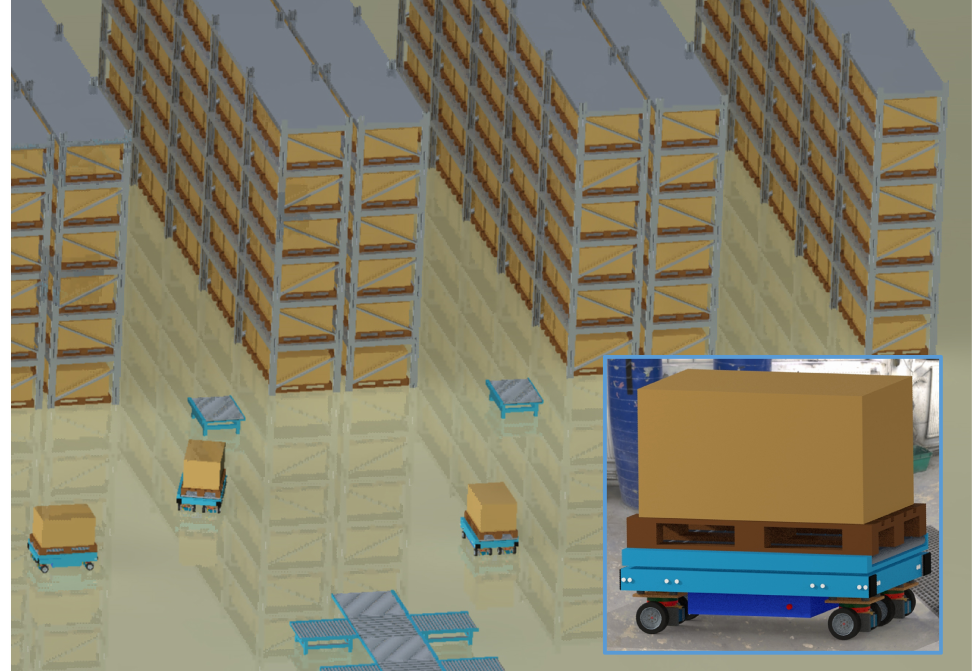
Figure 1. Automated guided vehicle (AGV) and operation